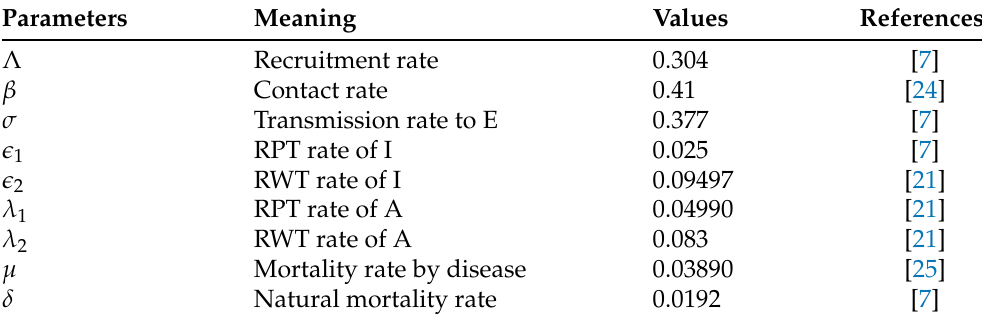
Table 4. Parameters used for the agent-based model.